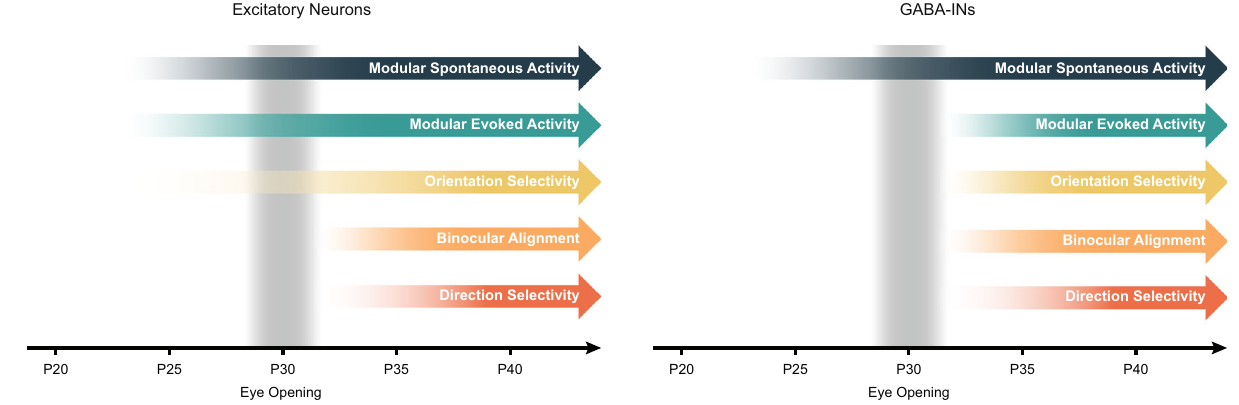
Fig. 6 Excitatory and Inhibitory neurons undergo distinct development trajectories of functional properties. Excitatory neurons display modular patterns activity for spontaneous and evoked activity and have initial orientation preferences established before eye opening. Subsequent visual experience aligns binocular and monocular orientation preferences and increases both orientation and direction selectivity. In contrast, GABA-INs only show modular patterns of activity for spontaneous activity before eye opening 45 . Modular evoked activity, orientation preferences and selectivity, binocular alignment, and direction selectivity all develop after eye